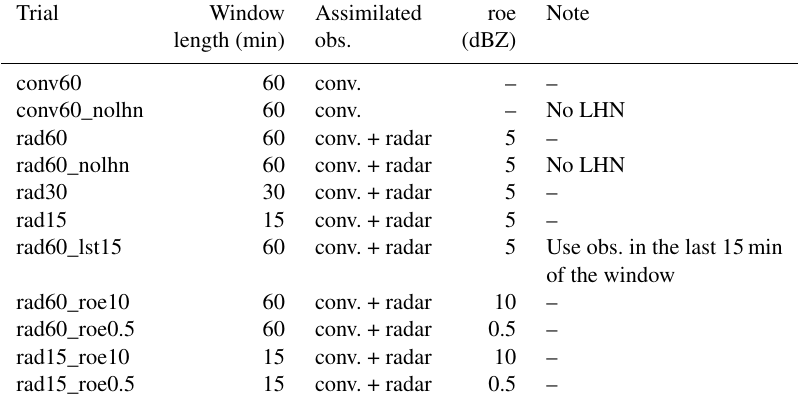
Table 1. Experimental set-up of each experiment, including the length of the assimilation cycles, the type of observations assimilated, the reflectivity observation error ( roe) associated with radar data and any additional feature.